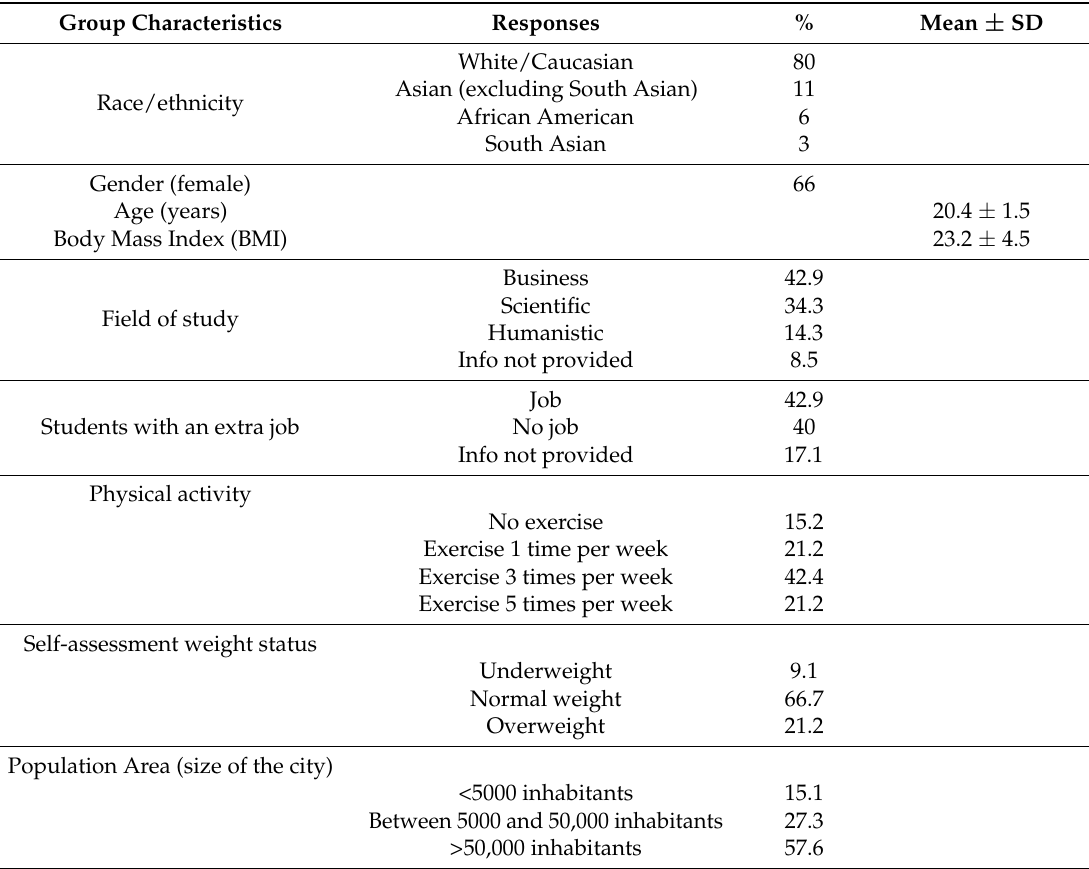
Table 2. Characteristics of focus group participants ( n =